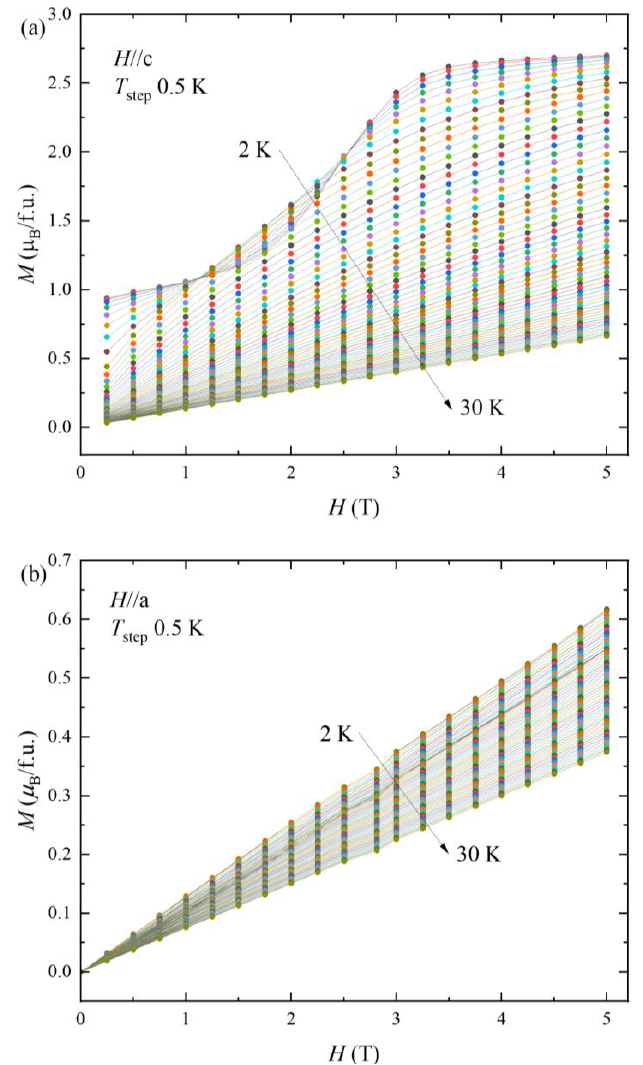
Figure 3. Isothermal magnetization versus applying magnetic field M(H) of NdAlGe along the H //c ( a ) and H//a ( b ).